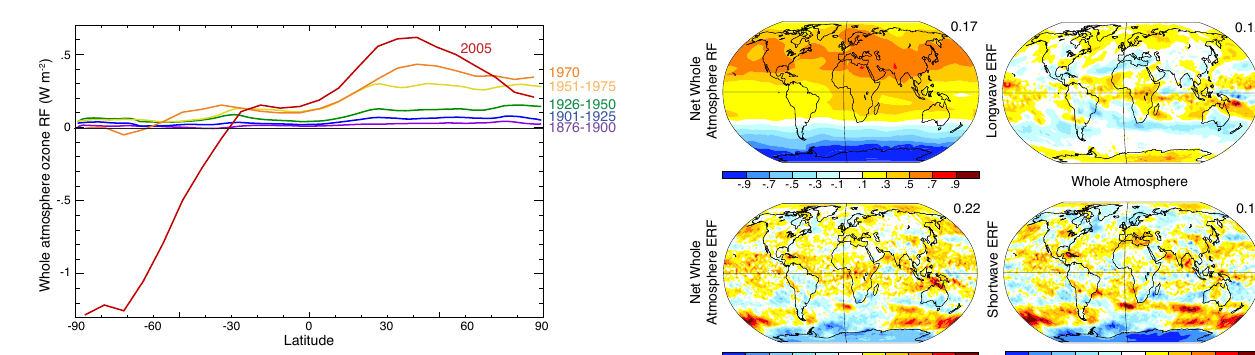
Fig. 17. Preindustrial to present-day ozone RF (top left) and ERF (lower left, right column) (Wm − 2 ) due to the ozone changes in the E2-R simulations. Note difference in scale for RF and ERF. The ERF values are from 40-yr runs. Global mean values are given in the upper right of each